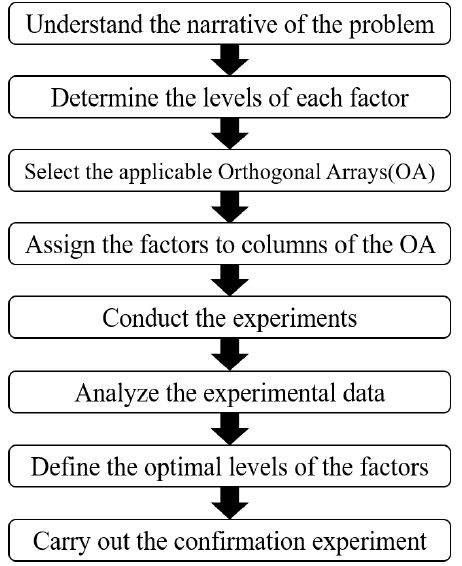
Figure 3. Flow chart of the Taguchi method.